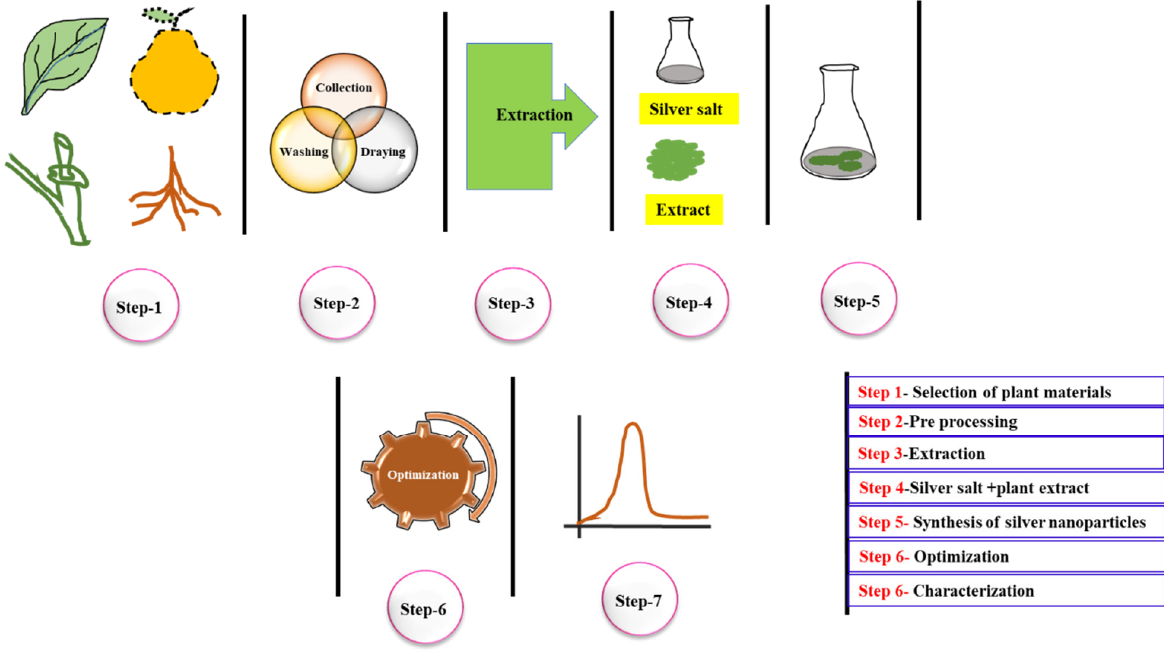
Figure 4. Schematic representation of plant extract ‐ based AgNPs synthesis process. 2.3. Comprehensive Analyses of Commercial Products Involving Silver Nanoparticle Synthesis Different commercial compounds used for silver nanoparticles are listed below. The major optimal conditions for the synthesis of AgNPs are also addressed to further gain insight into the pure compounds used for AgNPs production and various optimal parameters involved in the particular synthesis method (Table 1). Table 1. List of commercial reducing/capping agents involved in the AgNPs production.